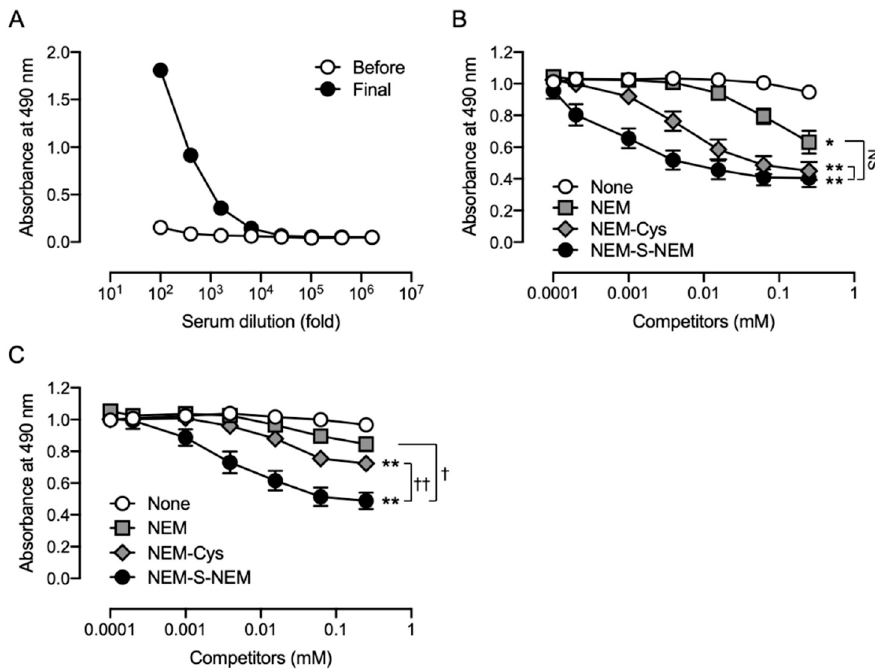
Figure 4. Characterization of rabbit polyclonal antibody. Japanese white rabbit was subcutaneously injected with NEM-S-MPA-conjugated BSA. The antibody titer in rabbit antiserum obtained from the immunized rabbit before the immunization ( before ) and 3 days after the last booster injection ( final ) was measured by ELISA with NEM-S-MPA-conjugated OVA as an antigen ( A ). Antibody specificity of the rabbit antiserum ( B ) and the flow-through (rabbit polyclonal antibody (pAb)) ( C ), which was obtained by applying the antiserum onto an affinity column to remove putative contamination of antibodies to recognize NEM-labeled thiols, was confirmed by a competitive ELISA using NEM-S-NEM, NEM-labeled cysteine (NEM-Cys), and NEM as competitors. NEM-Cys, NEM-labeled cysteine. * p < 0.001, ** p < 0.0001 vs none; † p < 0.001, †† p < 0.0001 vs. NEM-S-NEM, compared by Two-way ANOVA with Tukey’s multiple comparisons test.